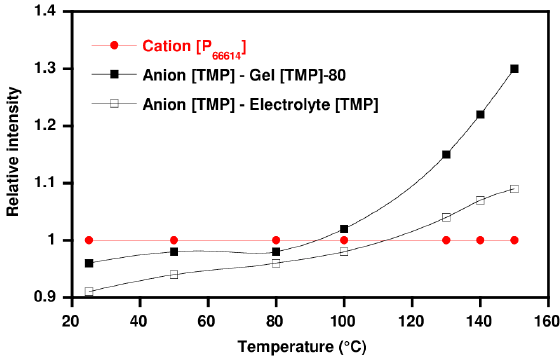
Figure 3. Evolution of the normalized relative intensity of the phosphinate anion compared to the relative intensity of the cation as a function of the temperature for the electrolyte [TMP] ([P66614][TMP] + 0.2 M LiTMP).